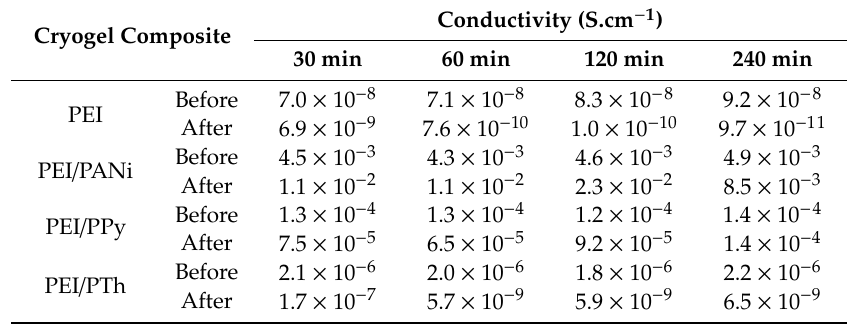
Table 1. The conductivities of bare PEI and PEI conductive polymer composites before and after CO 2 gas exposure at various times.